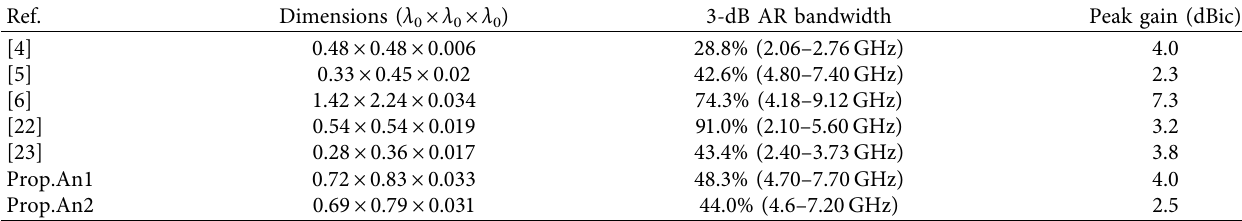
Table 4: Comparisons of the proposed and other CP